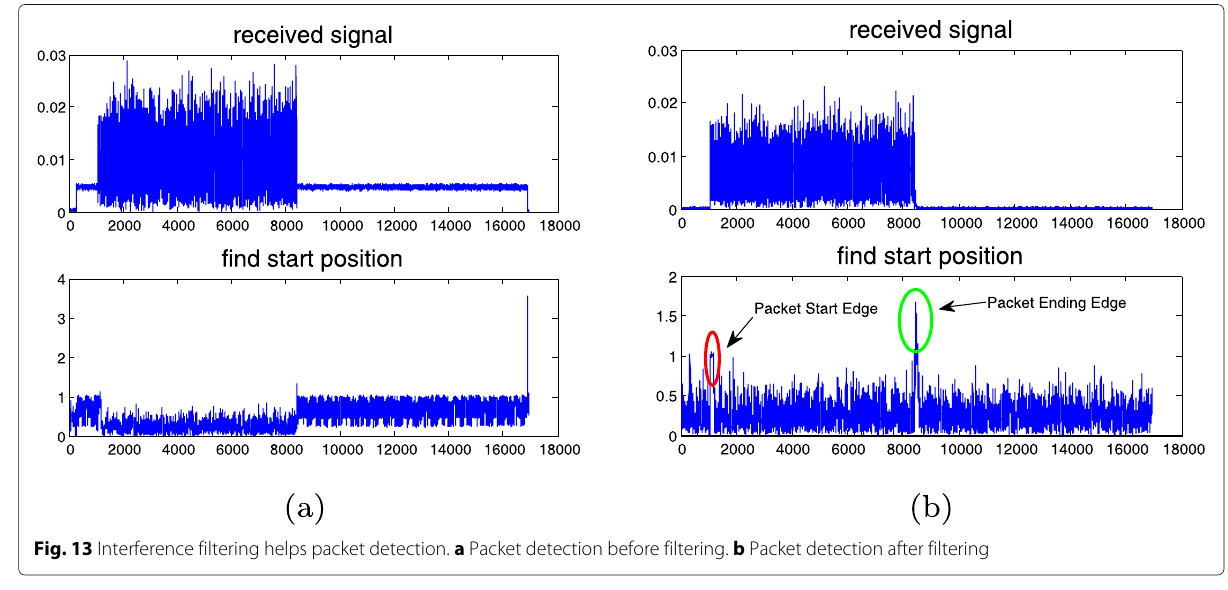
packet, which is marked in a red circle. This extra peak is due to the huge energy gap at the end of the WiFi packet, so it is easy to be identified.